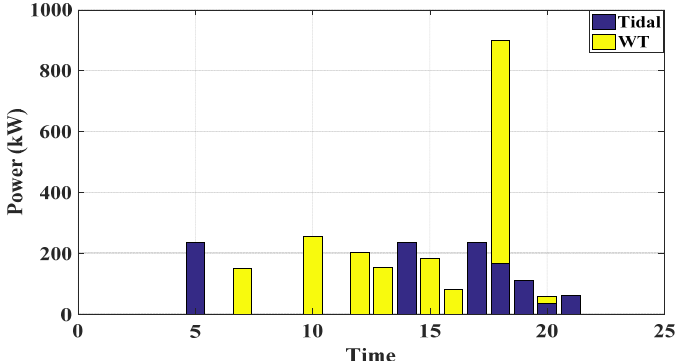
Figure 2. The generated powers of DC units including PV and fuel cell units.